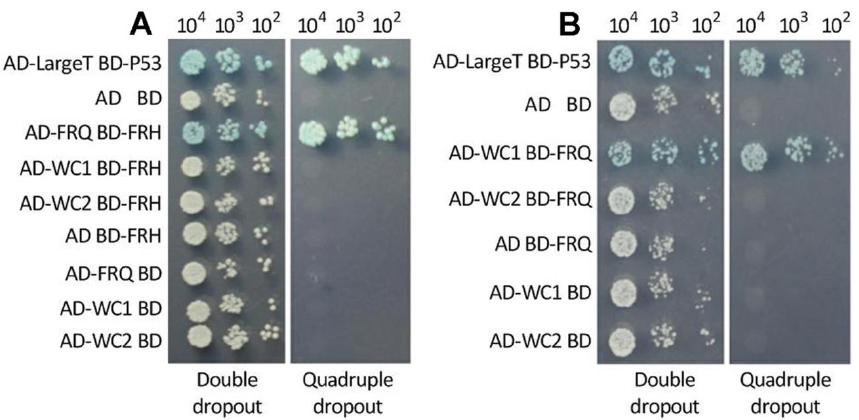
Figure 3. Y2H assay for protein–protein interactions. A positive interaction is indicated by the same growth capability of the constructed diploid AD-FRQ-BD-FRH ( A ) or AD-WC1-BD-FRQ ( B ) as the positive control (AD-LargeT-BD-P53) on the quadruple-dropout medium (SD/-Leu/-Trp/- Ade/- His/X-α-Gal/AbA). The colonies of each cell type were initiated with 1 μLaliquots of 10 5 , 10 6 , and 10 7 cells/mL suspensions and incubated for 3 d at 30 °C.